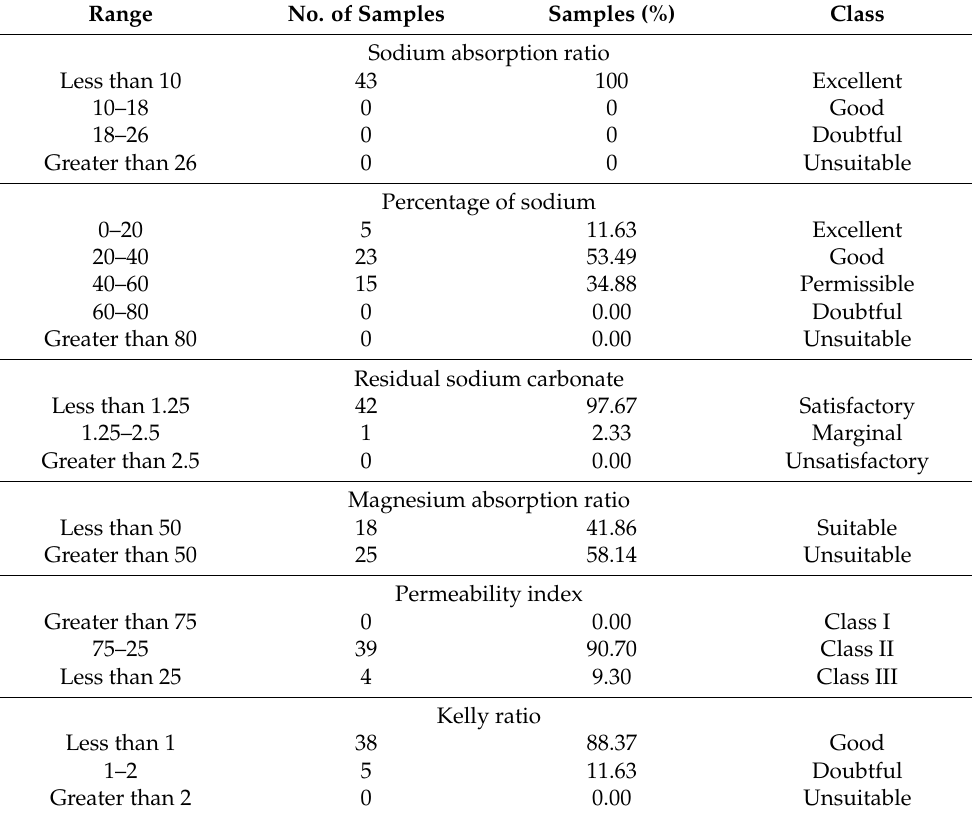
Table 4. Classification of groundwater based on irrigation indices.